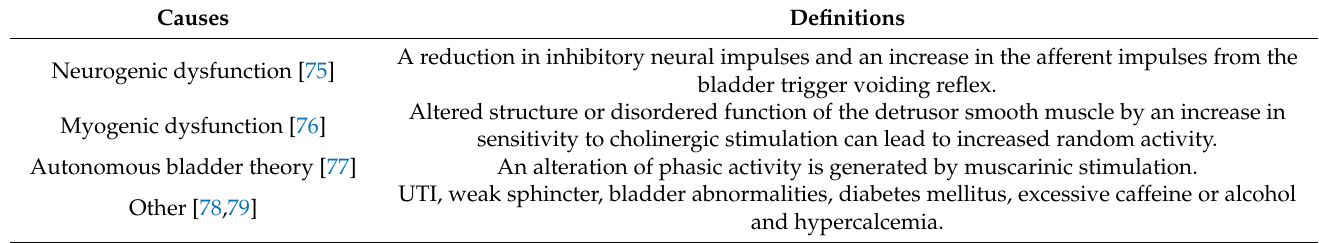
Table 2. Causes and definitions for